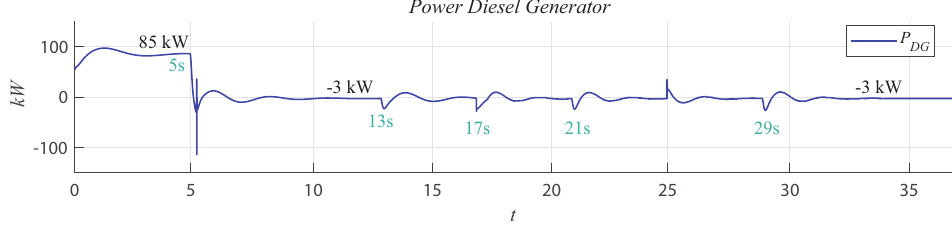
Figure 25. Power in the DG for case study 3.